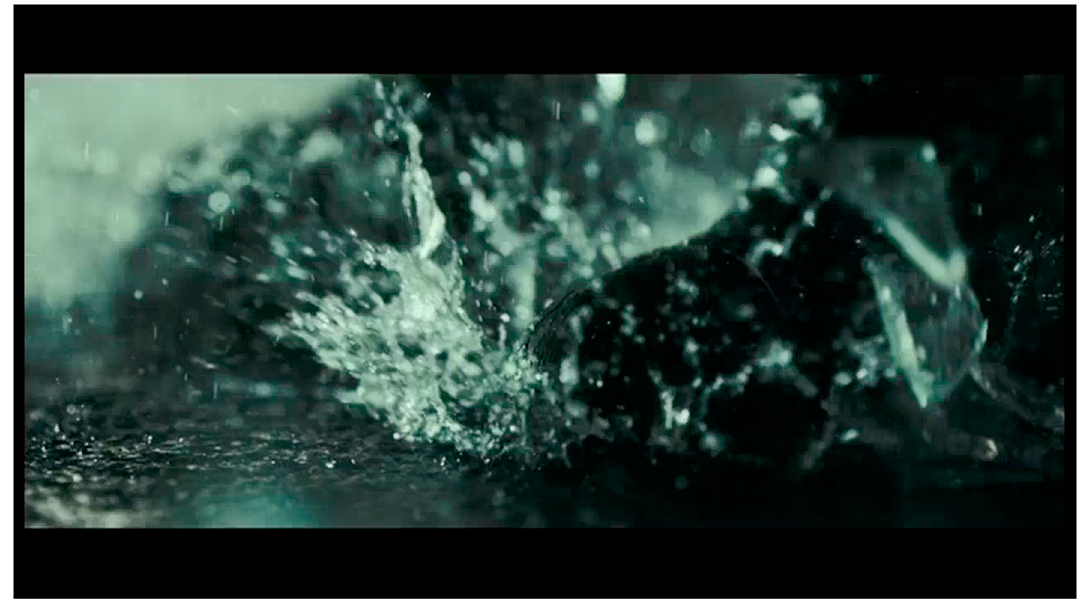
Figure 12. Crystalline splashes that capture the precise trajectory of water. Frame capture, The Grandmaster (Wong 2013).